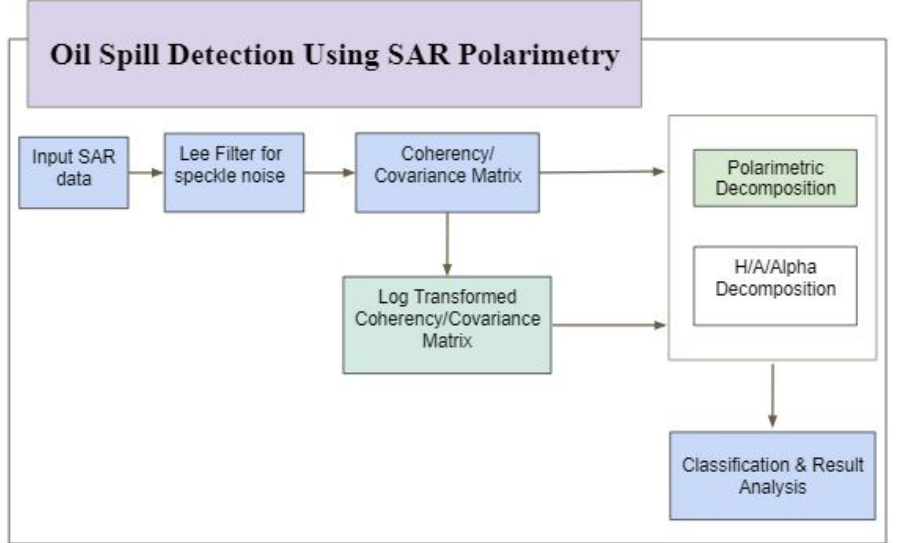
Figure 2. The proposed Log Transformation approach for efficient Oil Spill Detection using SAR Po-